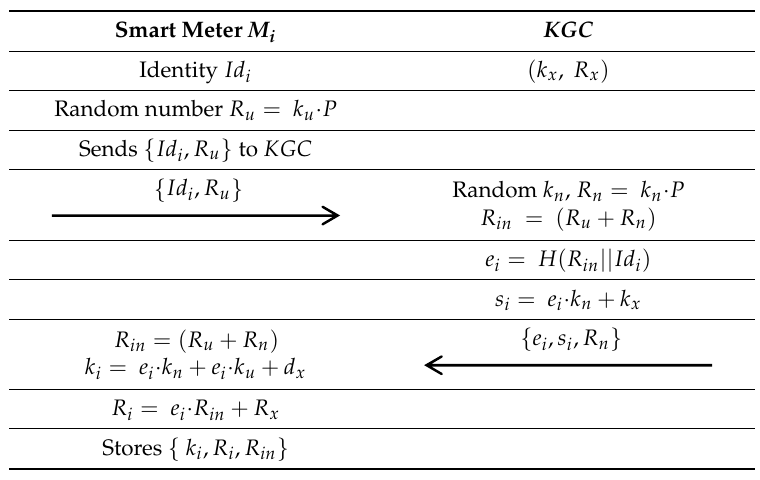
Table 6. Registration phase of the smart meter.